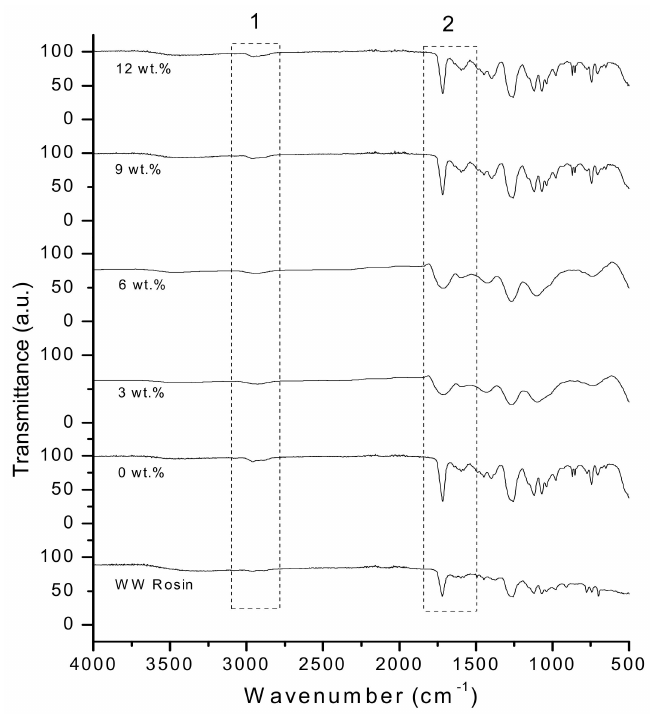
Figure 4. IR spectra of the WW rosin and coatings with di ff erent LLE wt. %.